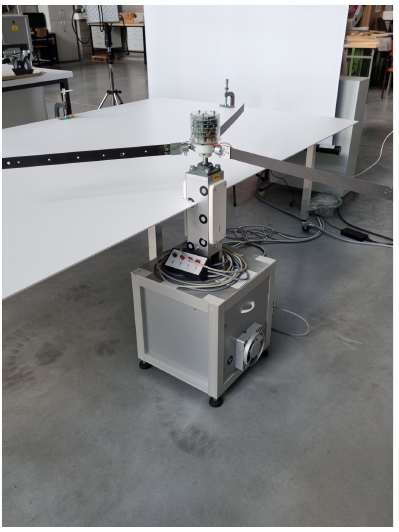
Figure 1. Three-bladed rotor—laboratory